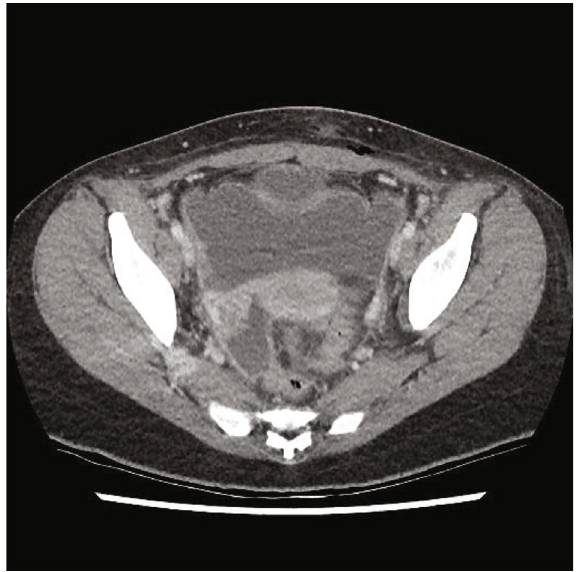
Figure 2: Enhanced abdominal CT scan fi ve days after initial CT scan and fi rst intervention showing increased amount of free pelvic fl